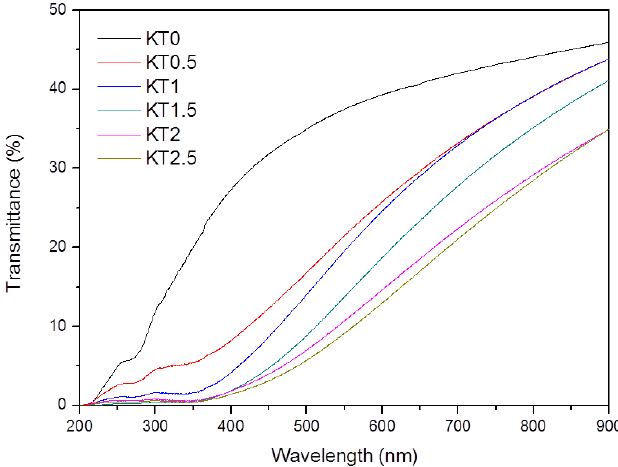
Figure 8. UV transmittance of the composite films (KT0.5~KT2.5).